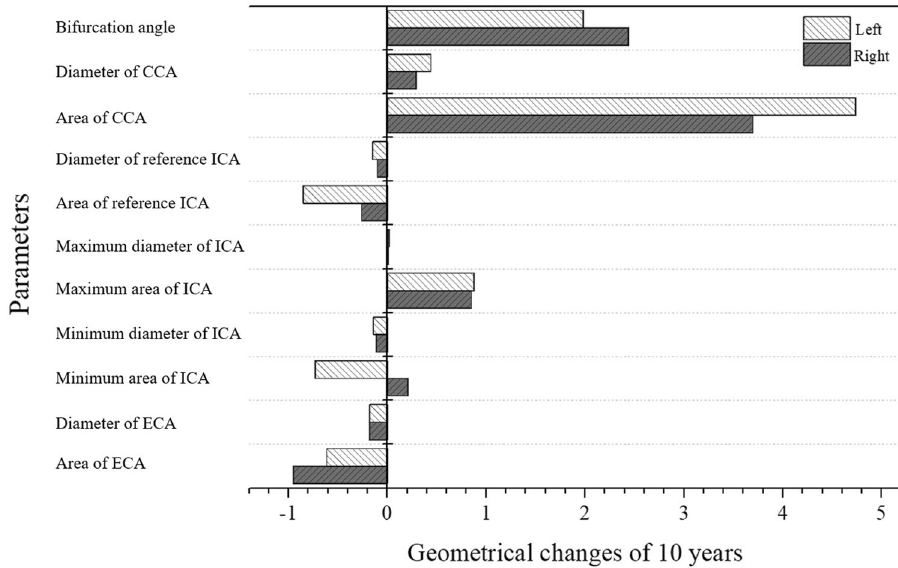
Figure 3. Geometric changes in bilateral carotid arteries over 10 years.